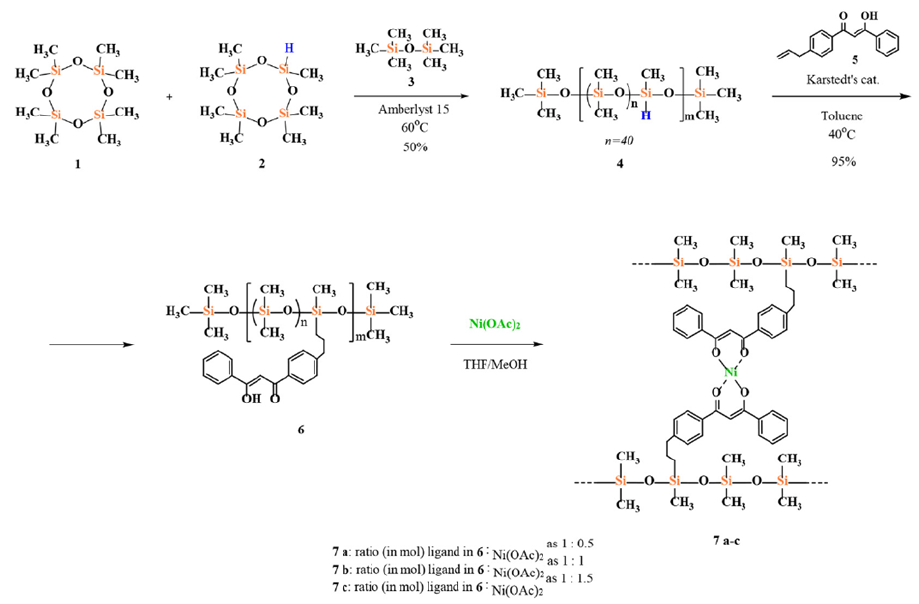
Figure 35. Preparation of cross-linked polymers based on polysiloxane and metal β -diketonate precursors (adapted with permission from Ref. [154, 2021, Kim, E.E.;).